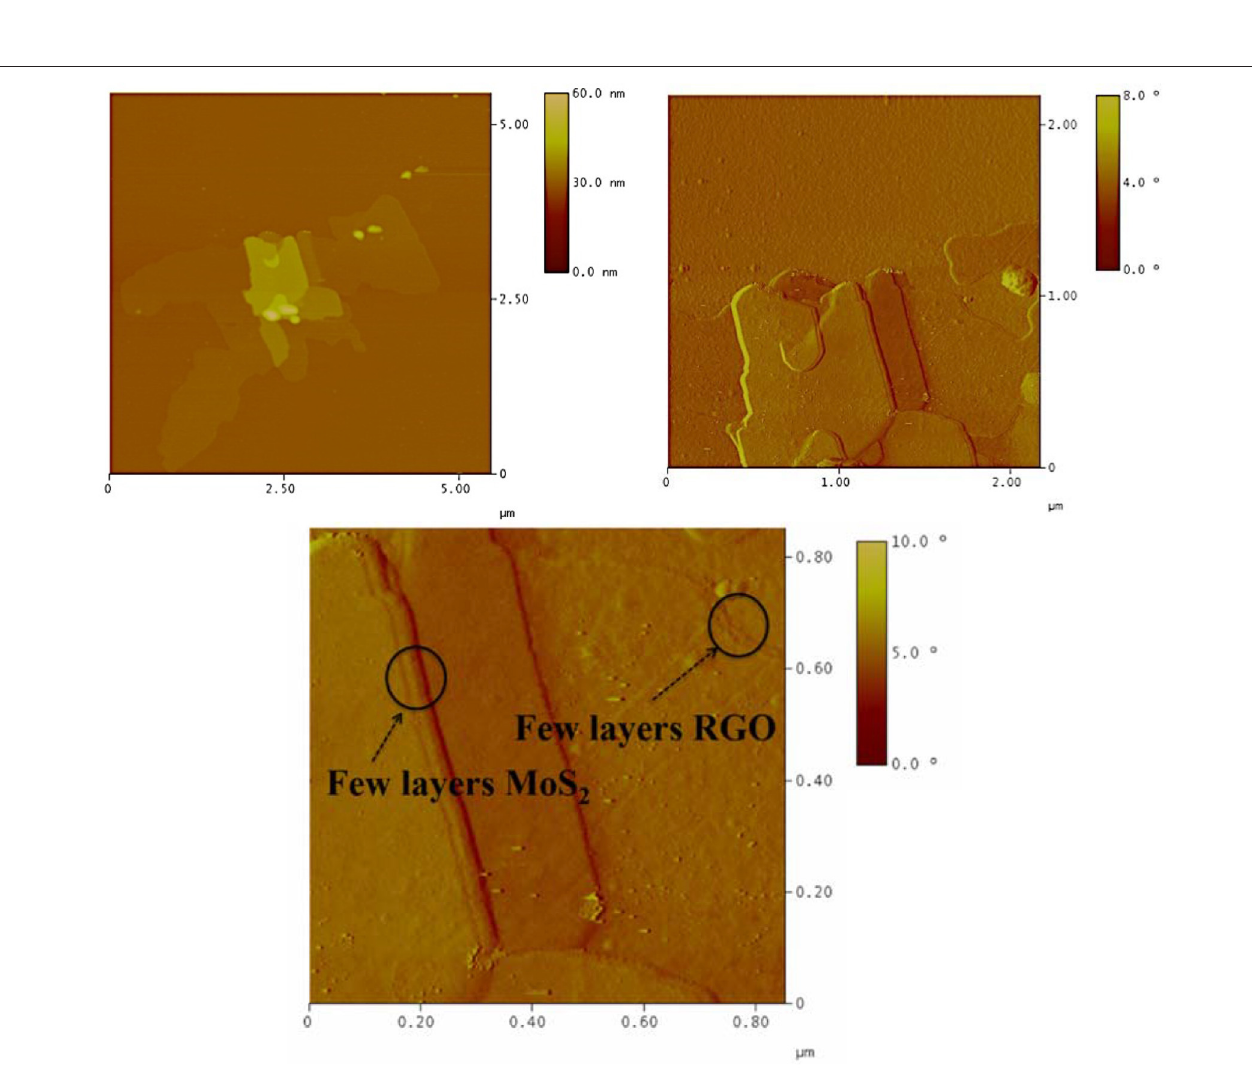
Frontiers in Materials | www.frontiersin.org